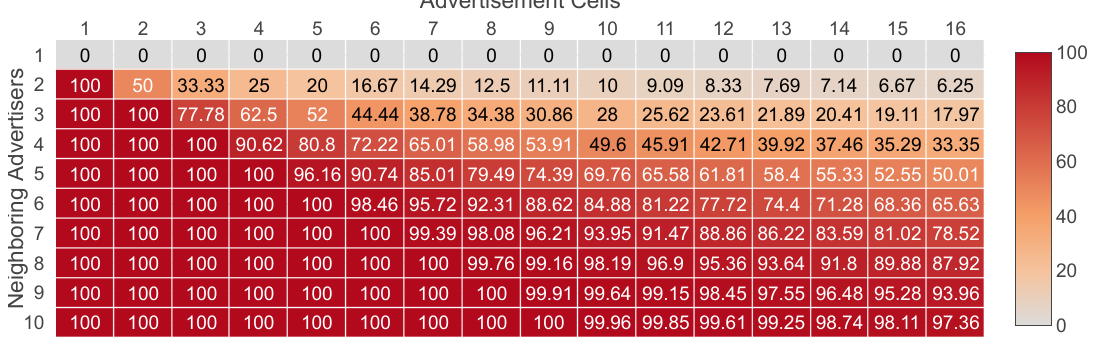
Figure 2. Probability of a collision (%) between the neighboring enhanced beacons (EB) transmissions of a joining node, when each advertiser transmits in a randomly selected advertisement